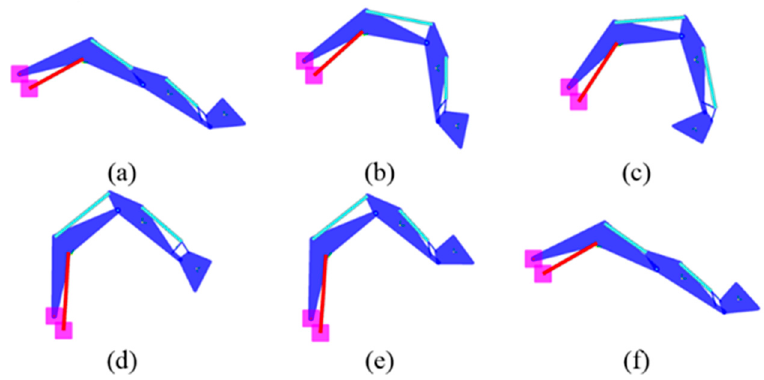
Figure 8. ( a – f ) Operation sequence of the front implement during digging cycle.